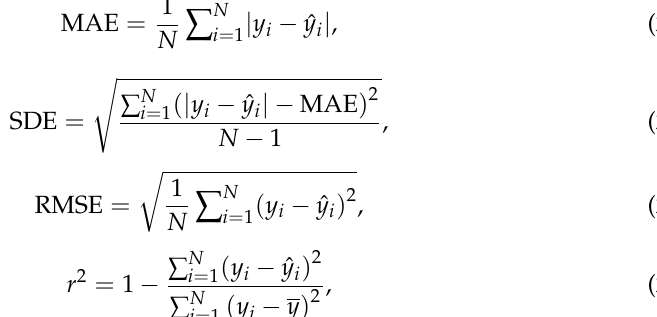
Figure 5. Estimated dominant wavelength ( a ) and azimuth cut-off wavelength ( b ) distributions based on number of images.